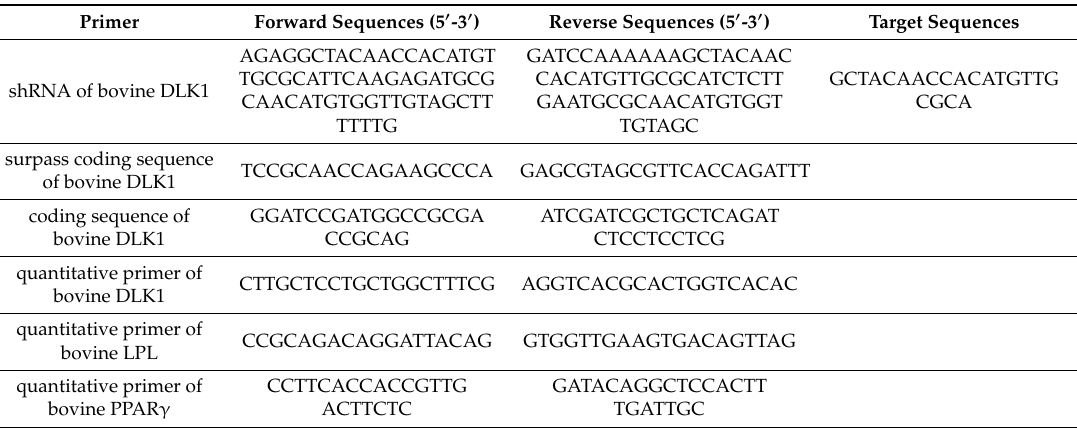
Table 1. The primer